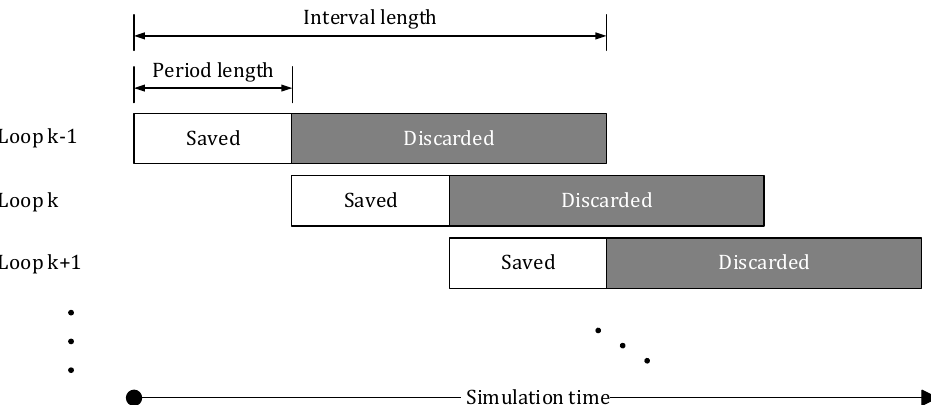
Figure 3. Simplified diagram of a rolling horizon with a ratio of period length to interval length of 1/3.